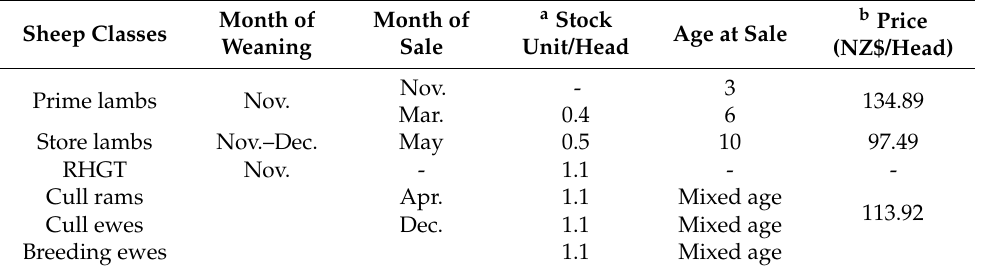
Table 3. Prime lambs (sold for meat processing), store lambs (sold to other farmers for finishing), replacement hoggets (4 to 16 months of age, mated at 8 months of age), cull ewes and rams (sold for meat processing), month of weaning and sale, stock unit/head, age at sale, and unit price